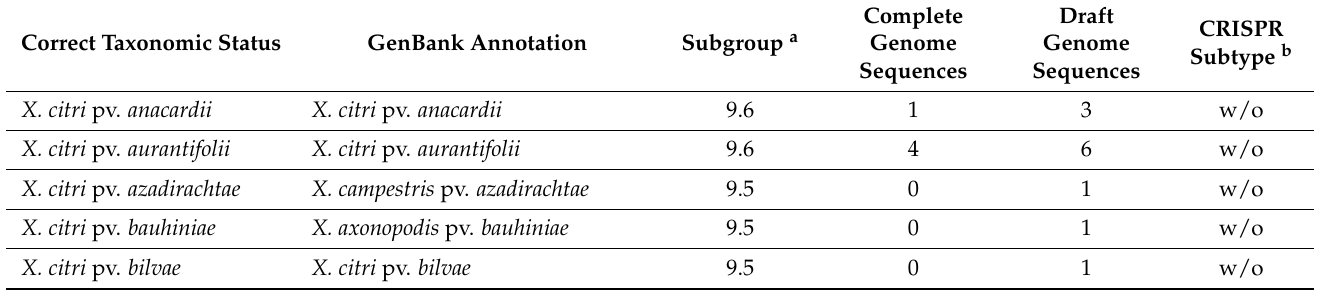
Table 1. Overview of genomic resources used in this study and presence of CRISPR Cas